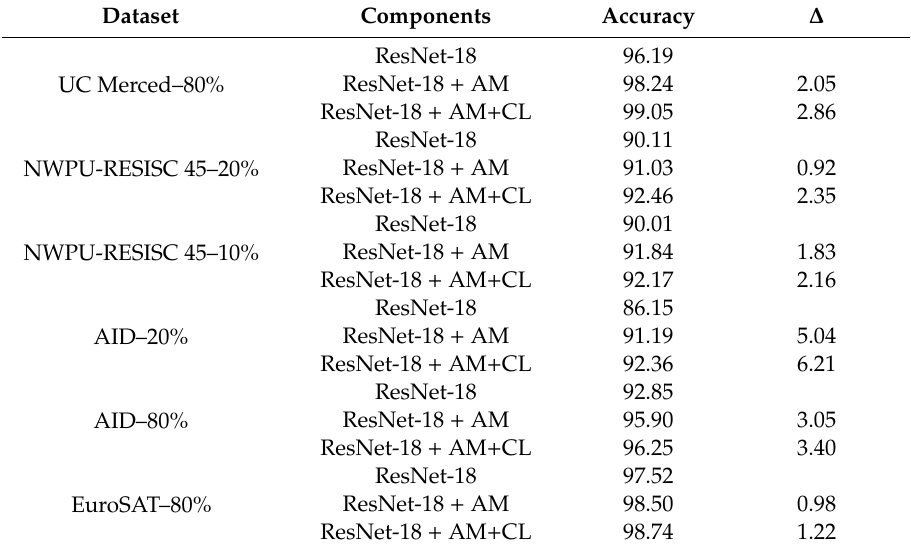
Table 6. Ablation study results (%) for our DDRL-AM model on di ff erent datasets.